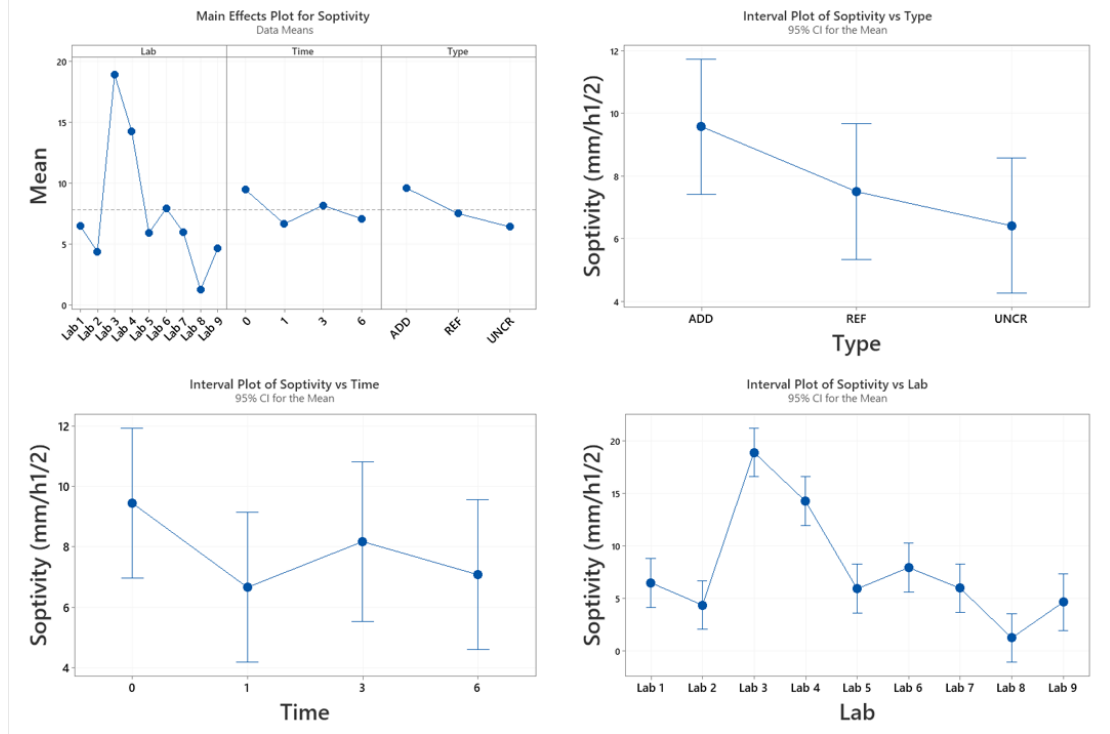
Figure 12. Main effects interaction plot for sorptivity coefficient.